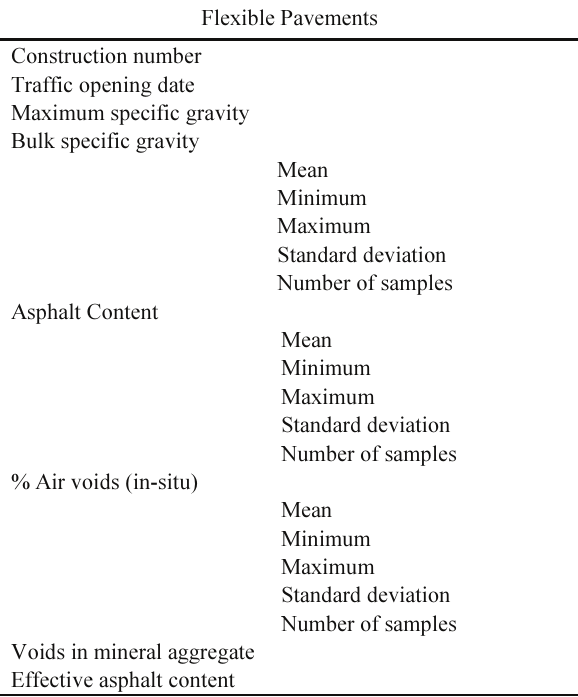
Table 1. Categories of data extracted from LTPP database for flexible